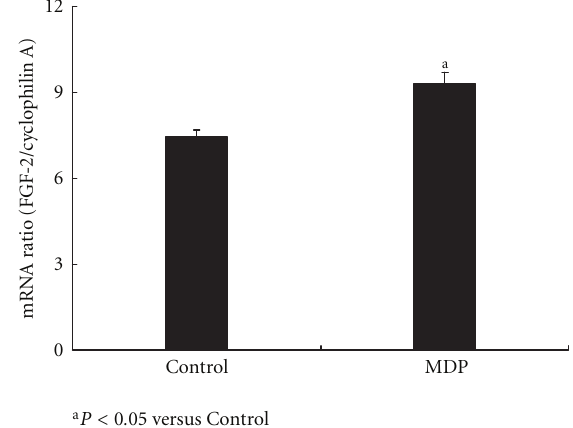
Figure 2: MDP stimulated FGF-2 mRNA expression in VSMC. FGF-2 mRNA expression increased in VSMC after 24-h MDP (10ng/mL) stimulation (9.32 ± 0.37 versus control 7.44 ± 0.25; a P < 0 . 05, n = 3). FGF-2 mRNA relative expression level = FGF- 2/cyclophilin